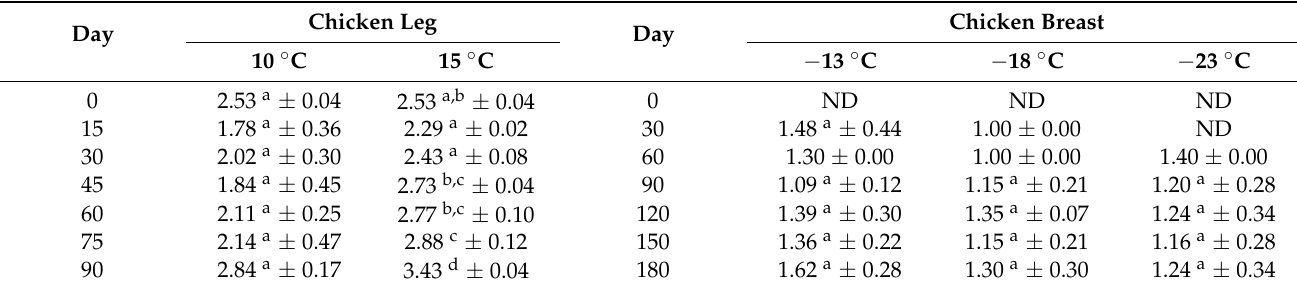
Table 9. Periodical values in the total bacterial count (TBC; Log CFU/g) of processed chicken products stored at different temperatures for different storage days (90 and